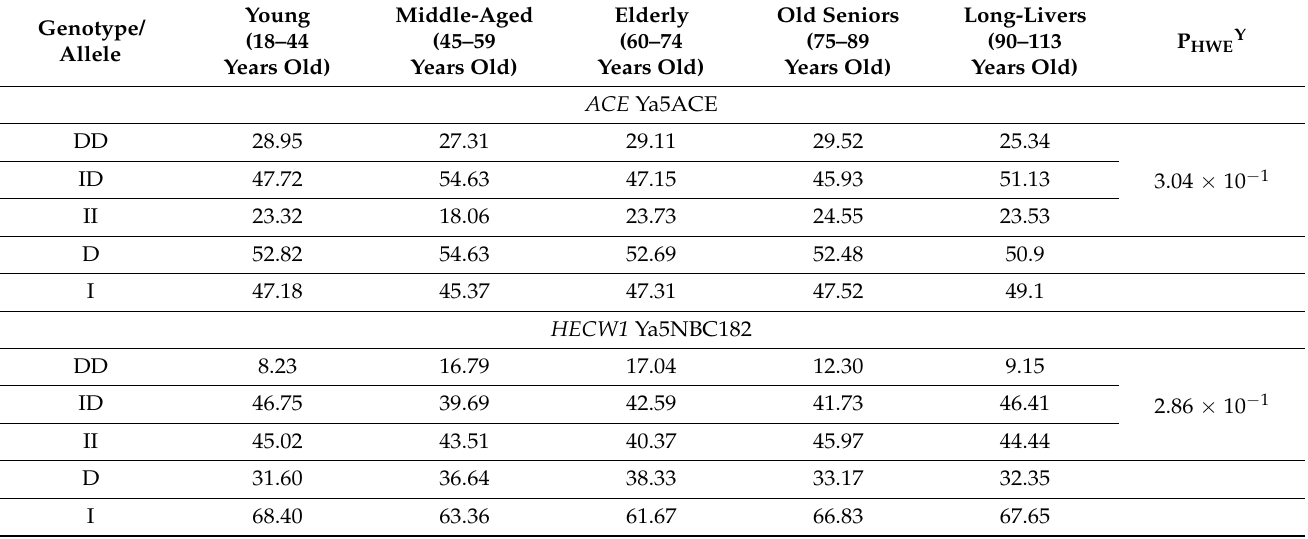
Table 1. Genotype frequencies (%) of the studied Alu polymorphic loci in age-divided groups.